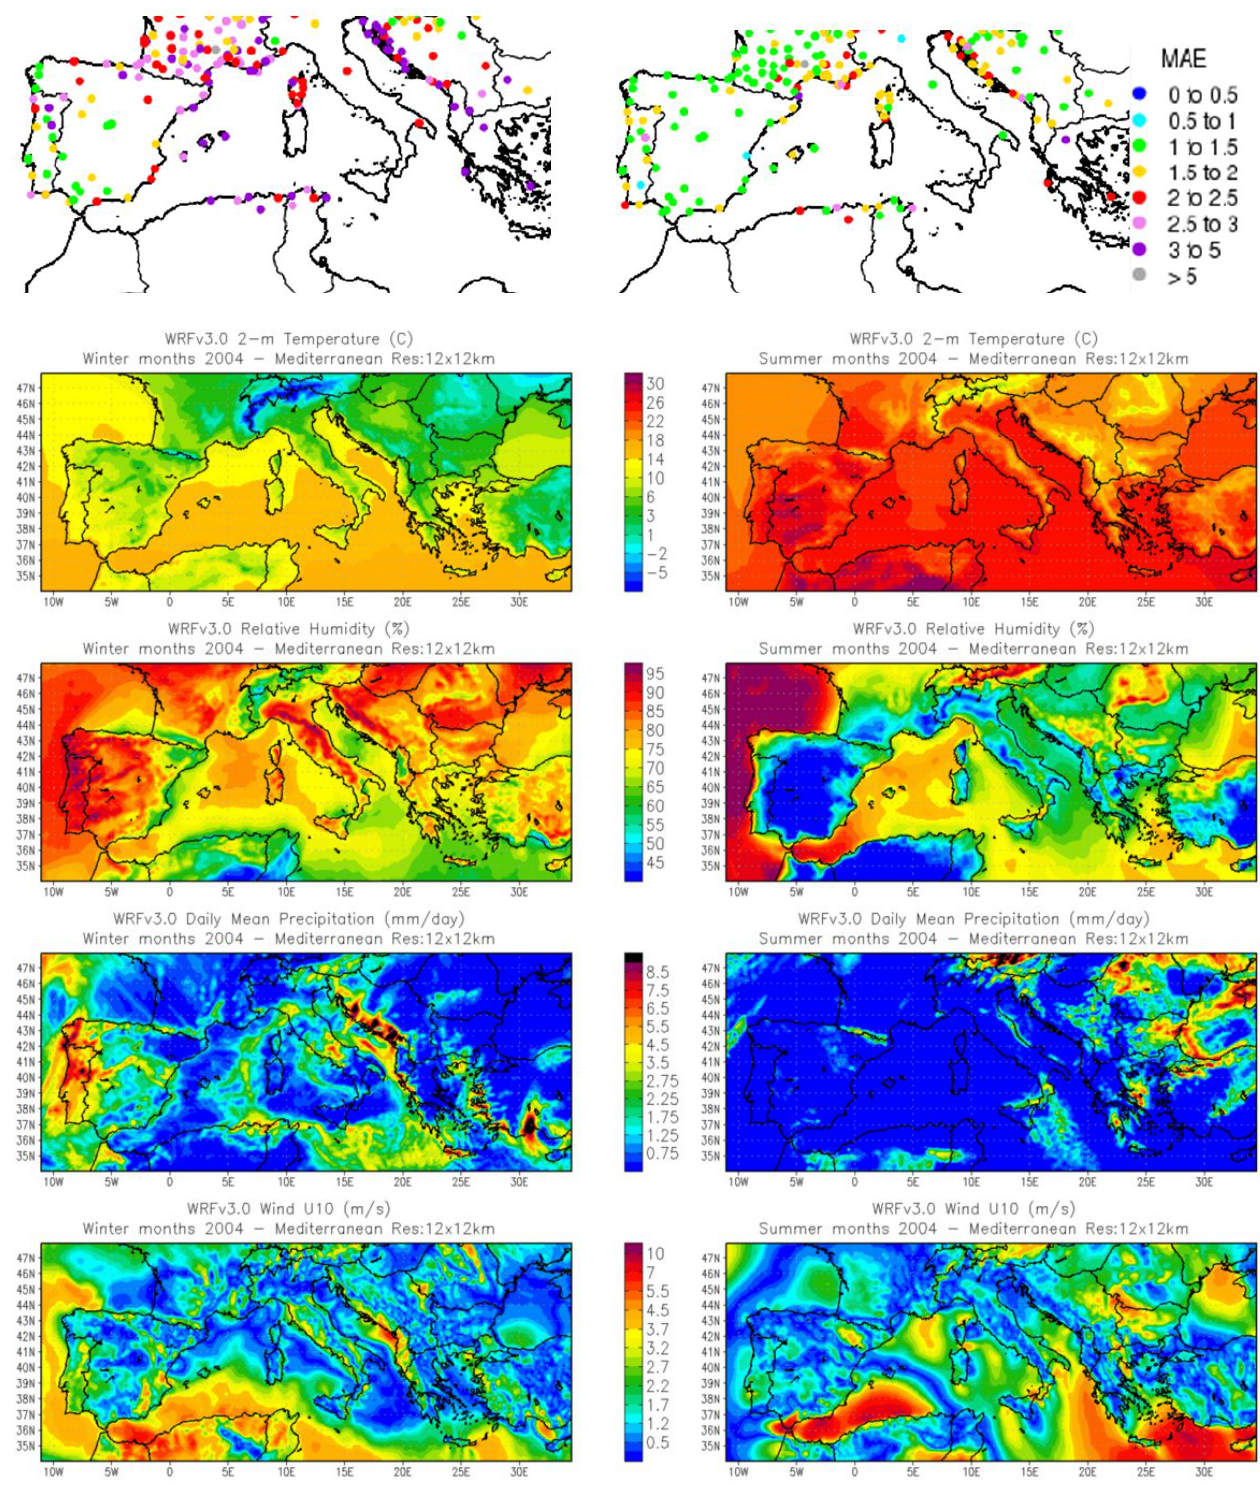
Fig. 1. (Top) map of the spatial distribution of the monthly MAE of 10-m wind speed (left) for January and (right) July 2004 (color legend in the right panel; units inms − 1 ); (down) seasonal averages of modeled meteorological fields involved in SSA production: winter (left) and summer (right) 2-m temperature ( ◦ C), relative humidity (%), precipitation (mmd − 1 ) and wind speed (ms − 1